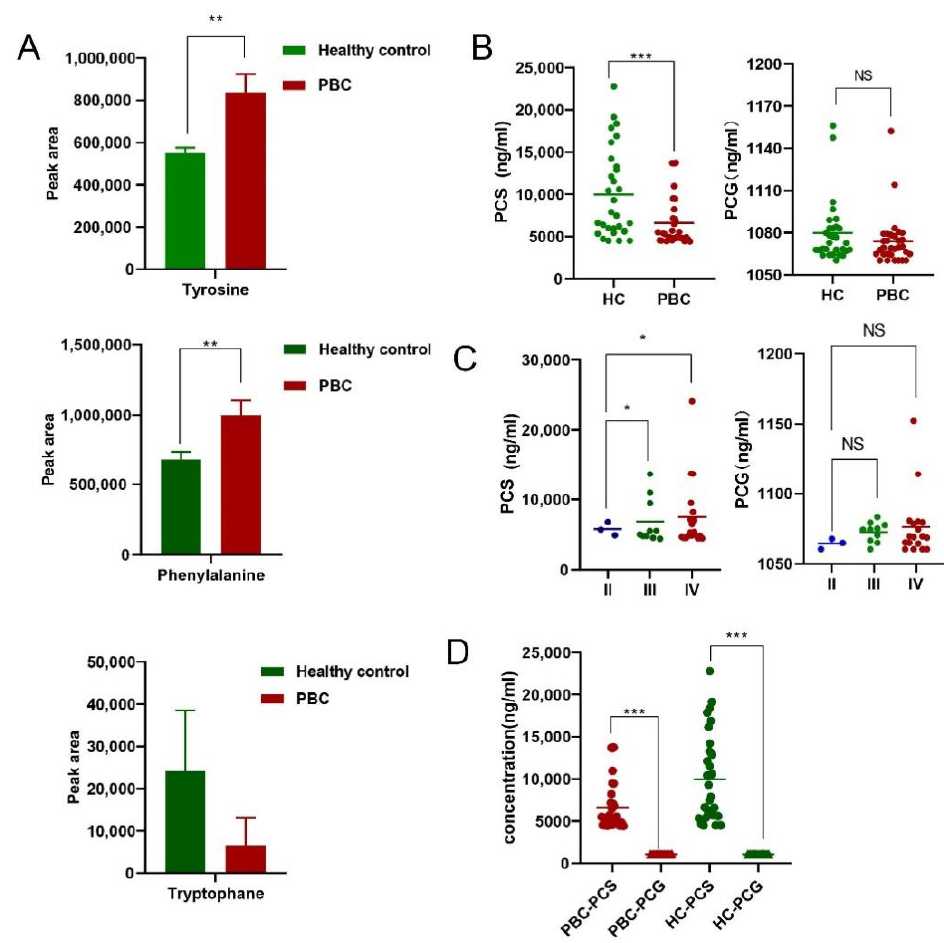
Figure 1. Aromatic amino acids and their metabolite end products PCS/PCG. ( A ) Differences in the peak areas of tyrosine, phenylalanine, and tryptophan between groups. ( B ) Concentration distribution of PCS and PCG between groups. ( C ) Distribution of PCS and PCG at different clinical stages of PBC. ( D ) Concentration distribution of PCS and PCG between groups. * p < 0.05, ** p < 0.01, and *** p < 0.001. NS: no significance.